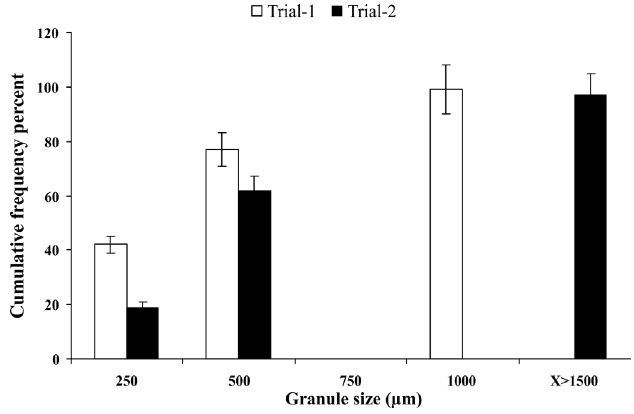
FIGURE 1 - Granule size distribution. TABLE II - Content of DHA granules as a function of particle size Size of Particles (µm)